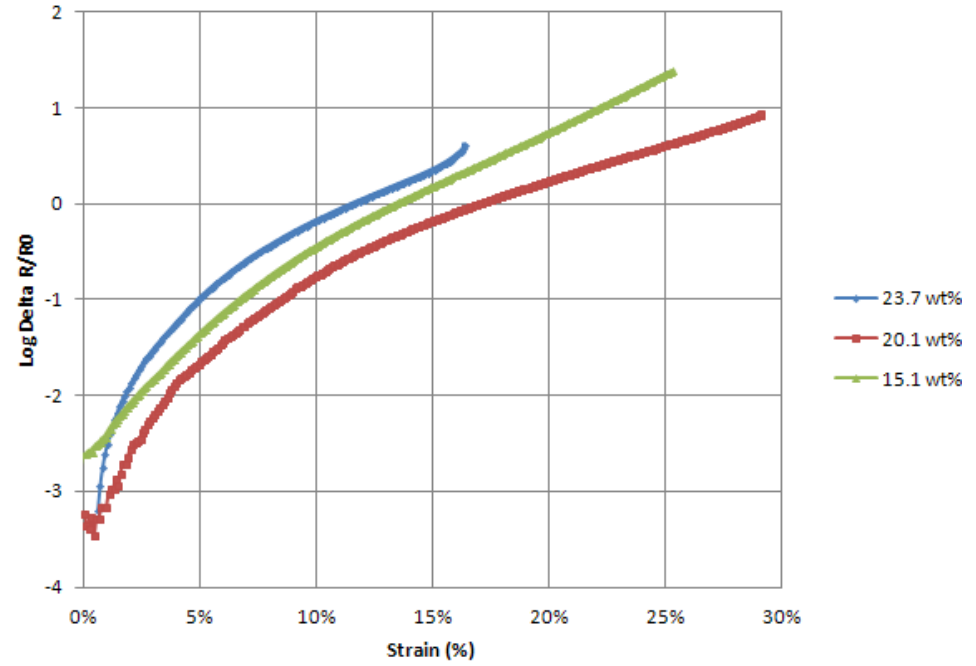
Figure 6. Delta R/R vs. Strain of three pure coating films with several ratios of dry 0 CPP105D to